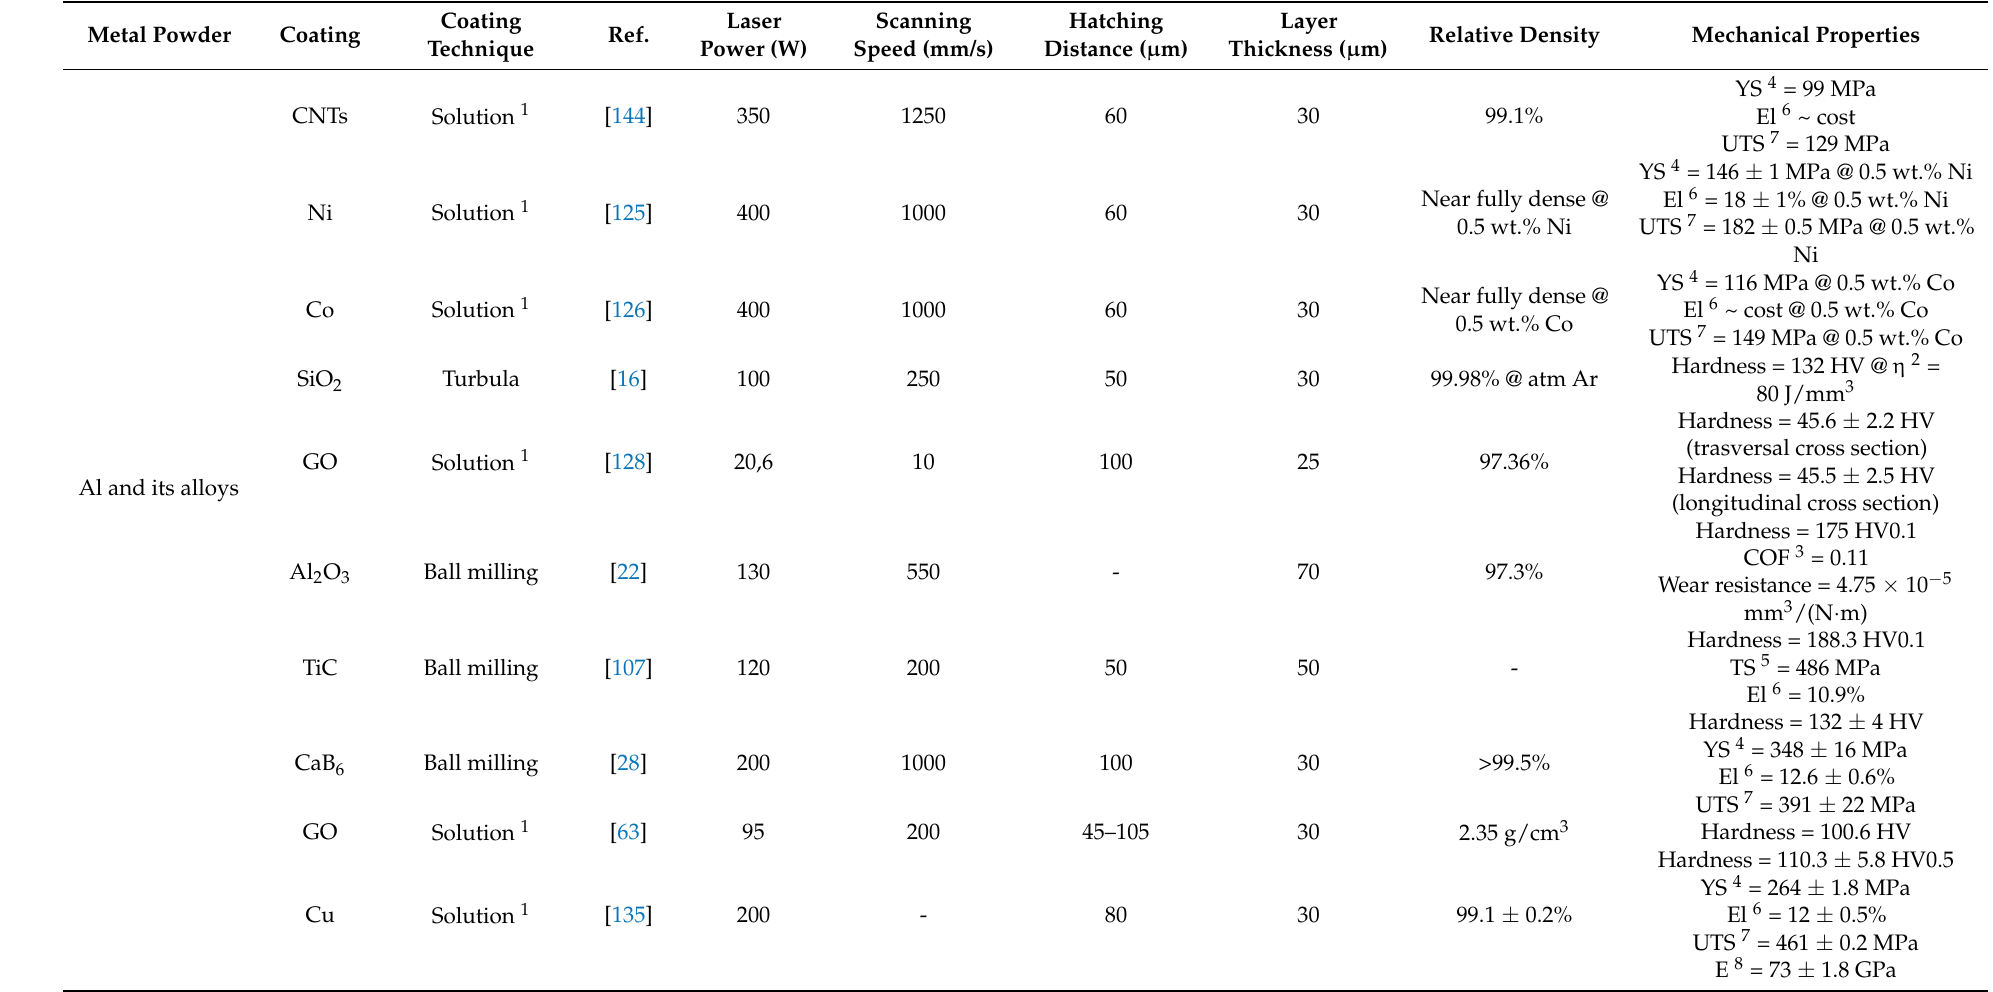
Table 4. A summary table reporting L-PBF process parameters, relative density and mechanical properties of printed parts using Al-based